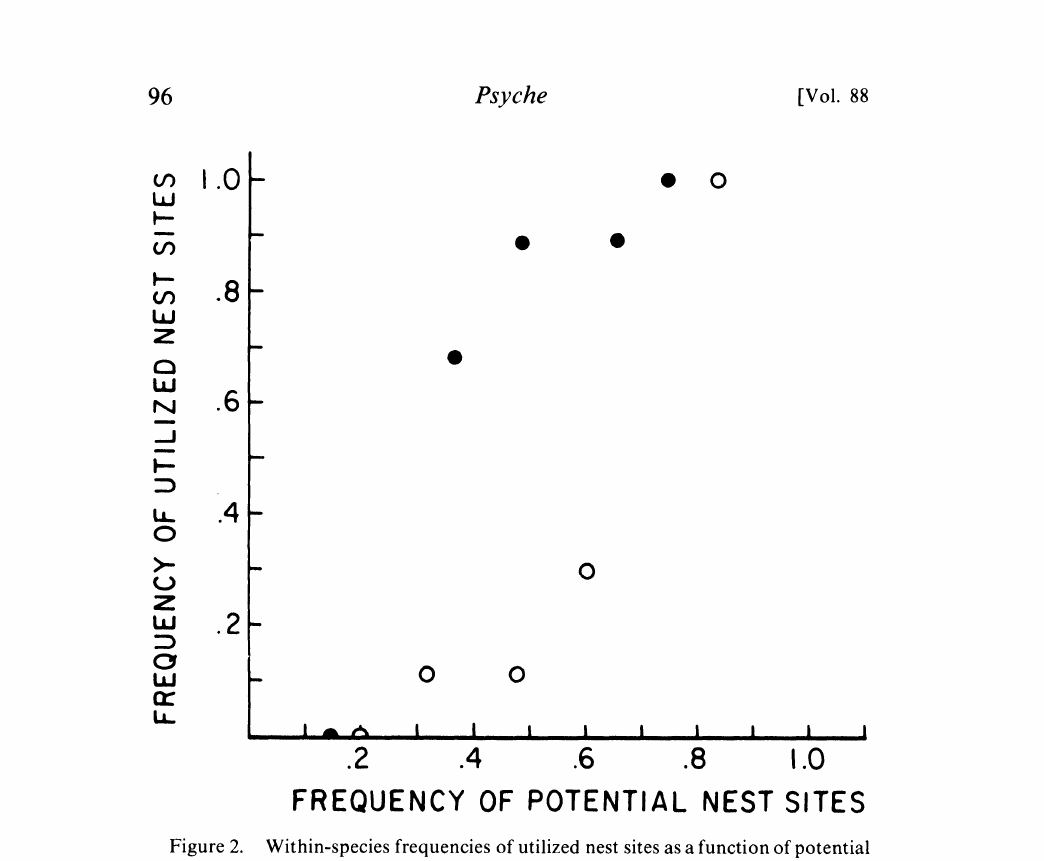
Figure 2. Within-species frequencies of utilized nest sites as a function of potential nest site frequencies, for 5 impressa group species. Closed circles refer to log nest sites, open circles to